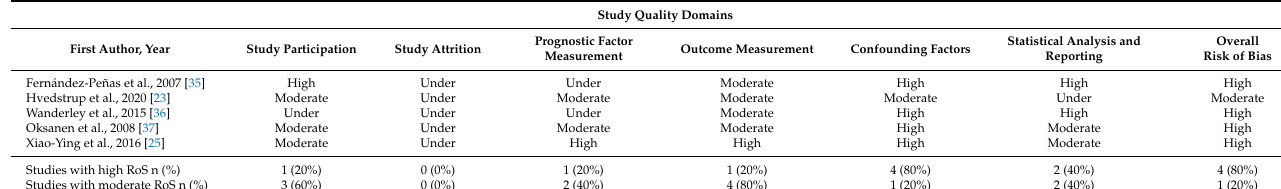
Table 2. Risk of Bias domains. This table shows the different domains of the risk of bias (RoB) assess- ment performed with the QUIPS tool. It represents the six domains assessed: study participation, study attrition, prognostic factor measurement, outcome measurement, potential confounders, and statistical analysis and reporting of statistical data.